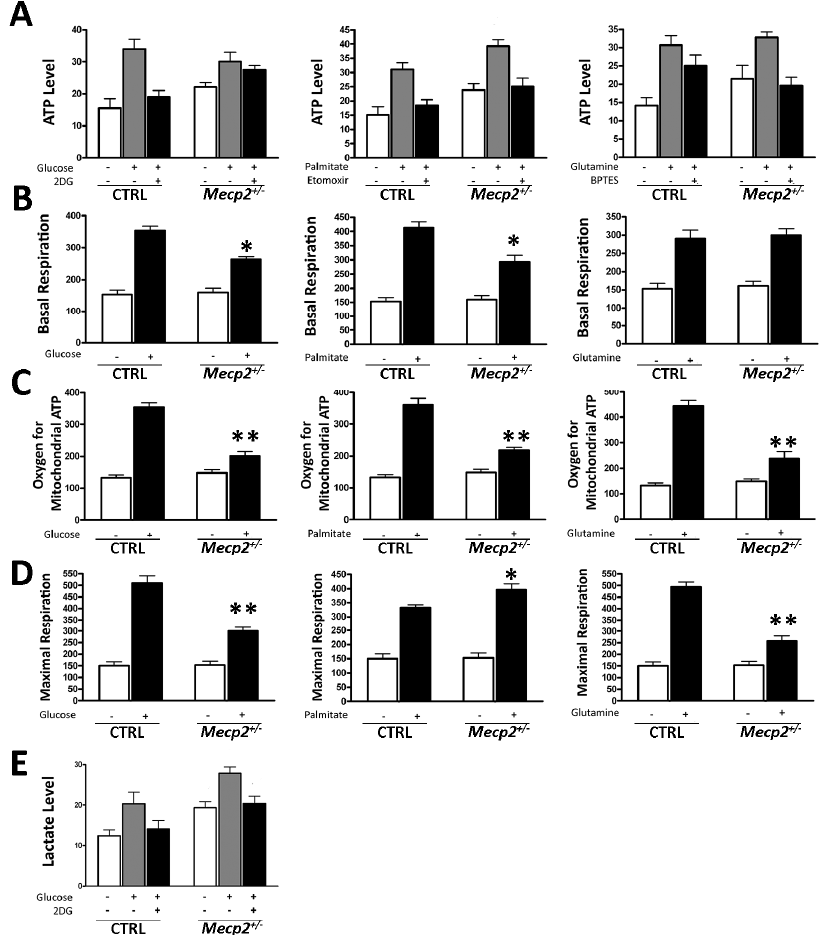
Figure 3. Evaluation of metabolic activity. ( A ) Intracellular ATP level evaluation by the ATP colorimetric/fluorometric assay. The cells were incubated in a medium containing glucose (left graph), palmitate (middle graph), or glutamine (right graph). The ATP level was measured in the absence of an energy substrate (white bars), in the presence of a specific substrate (gray bars), and in the presence of a substrate and its inhibitor (black bar). The data are expressed as ATP concentration (nM) (±SD, n = 5 biological replicates). ( B ) Basal oxygen consumption rate. We used the MitoXpress® Xtra assay for measurement of extracellular oxygen consumption rates (OCR). Cells were incubated in a medium containing glucose (left graph), palmitate (middle graph), or glutamine (right graph). For every condition, the asterisk (*) denotes significant differences ( p < 0.05) between OCR in the Mecp2 +/ − versus CTRL MSCs. Data are expressed in arbitrary units (±SD, n = 5 biological replicates). ( C ) Oxygen for mitochondrial ATP production. OCR was measured following sequential addition of oligomycin that is an inhibitor of the F0 part of H+/ATP synthase in mitochondria. The cells were incubated in a medium containing glucose (left graph), palmitate (middle graph), or glutamine (right graph). For every condition, the asterisk denotes significant differences (** p < 0.01) between OCR in Mecp2 +/ − versus CTRL MSCs. Data are expressed in arbitrary units (±SD, n = 5 biological replicates). ( D ) Maximal respiration rate. OCR was measured following sequential addition of FCCP, that is, a protonophore and uncoupler of oxidative phosphorylation in mitochondria. The cells were incubated in a medium containing glucose (left graph), palmitate (middle graph), or glutamine (right graph). For every condition, the asterisk denotes significant differences (* p < 0.05; ** p < 0.01) between maximal OCR in the Mecp2 +/ − versus CTRL MSCs. Data are expressed in arbitrary units (±SD, n = 5 biological replicates). ( E ) Lactate level evaluation by the Lactate Assay Kit. The cells were incubated in a medium containing glucose with and without 2D-glucose, an inhibitor of glycolysis flux. The data are expressed as lactate concentration (nM) ( ± SD, n = 5 biological